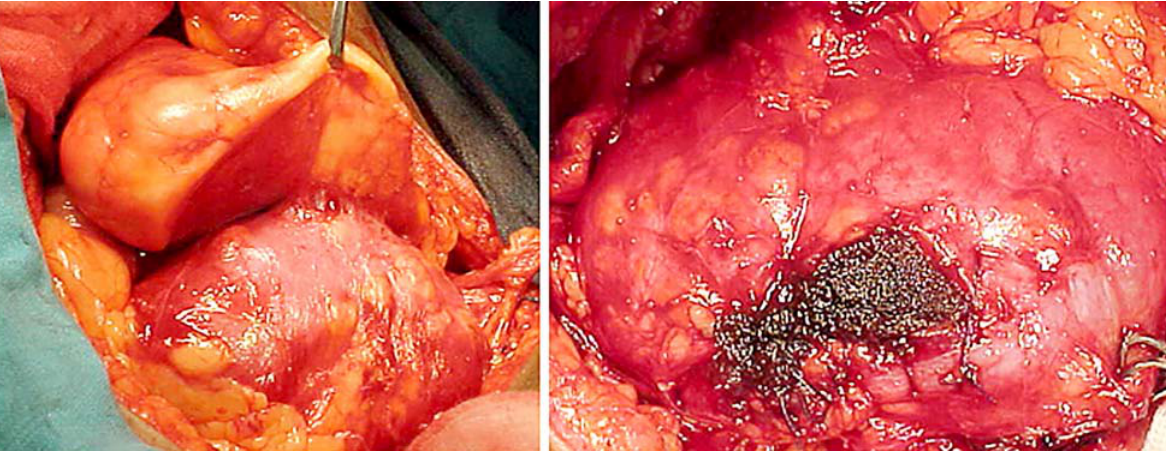
Figure 4 – Intraoperative view of case 2 (before and after removal) showing encapsulated tumor fixed to the